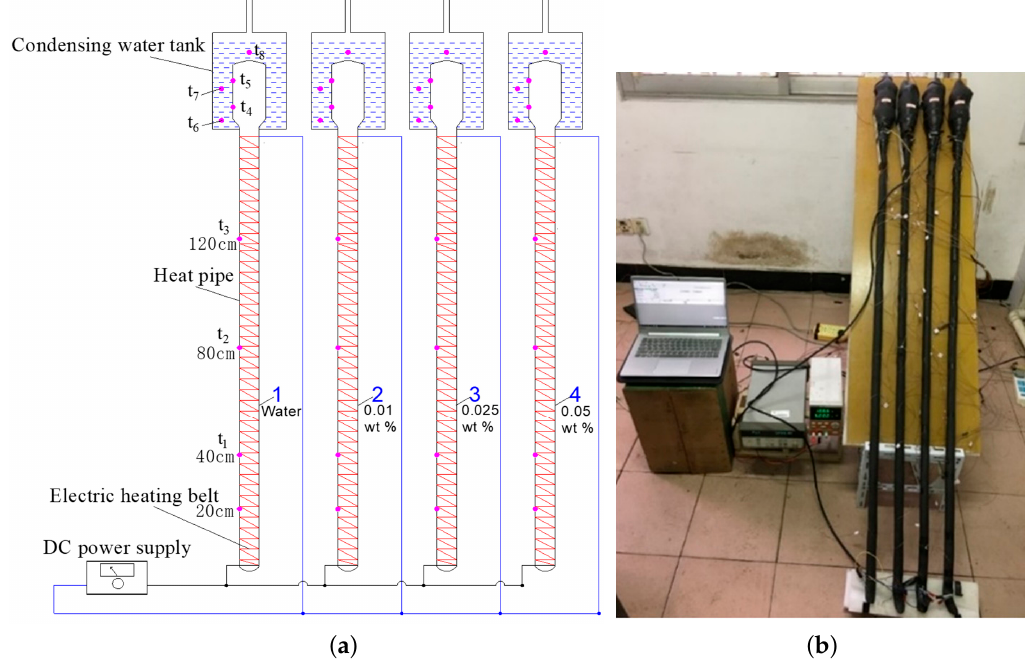
Figure 8. Schematic diagram and setup of the comparative experiment for solar gravity heat pipes. ( a ) Schematic diagram; ( b ) Photograph of the experimental setup.